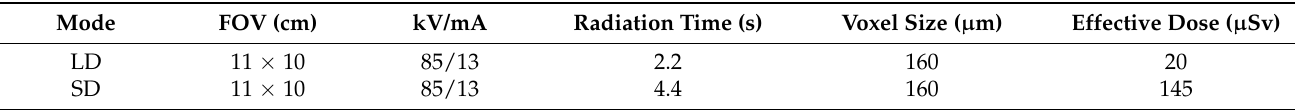
Table 1. This table shows the settings of the low-dose and standard-dose cone-beam computed tomography (CBCT) protocols of the Orthopos SL (Dentsply Sirona, York, PA, USA) dental X-ray imaging unit. Mode FOV